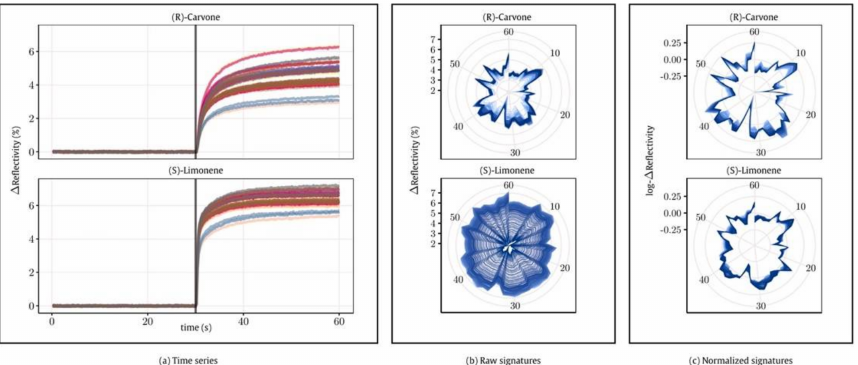
Figure 5. ( a ) Example of time series obtained for R -carvone and S -limonene. ( b ) Raw signatures in polar coordinates (angle for spot number and radius for amplitude). ( c ) Normalized signatures: repeatability is visibly increased (compared to ones reported in ( b )). Adapted from Ref. [4] with permission from Elsevier, copyright